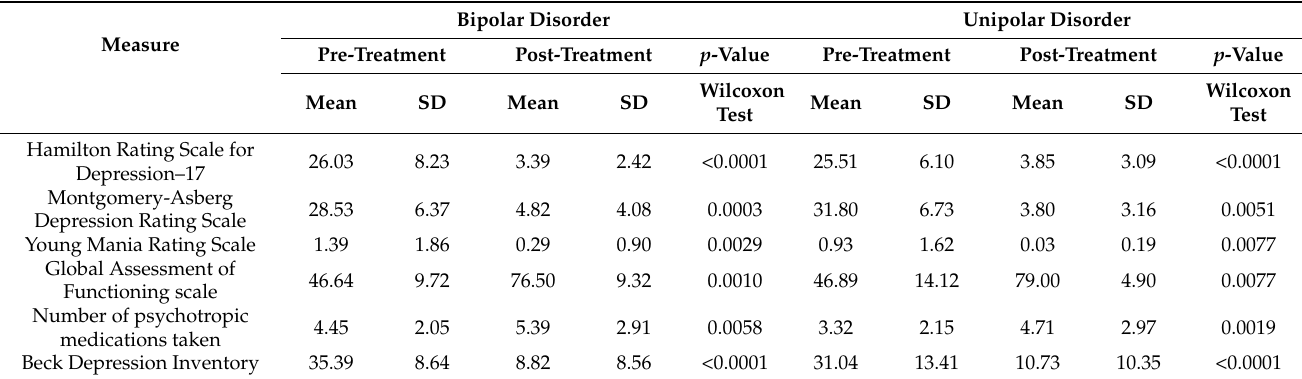
Table 2. Questionnaire total score for the study